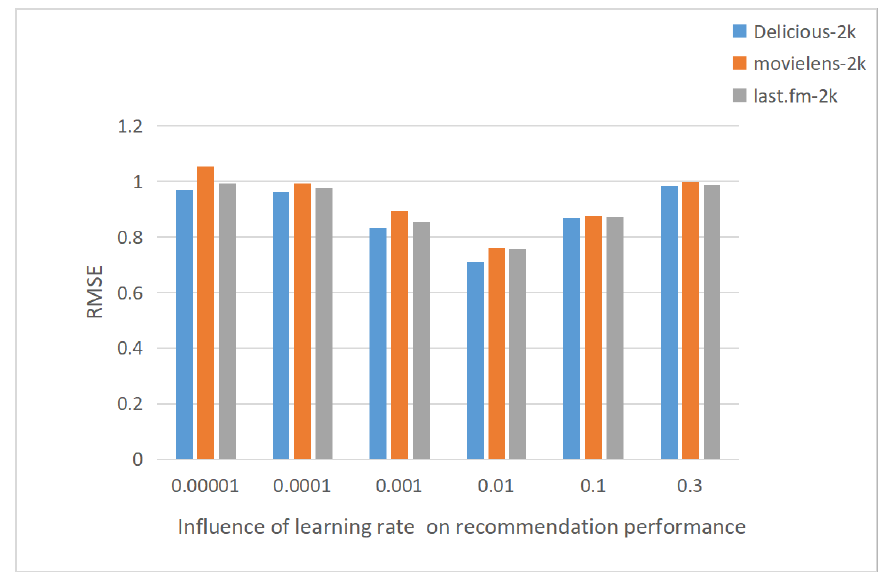
Figure 6. Influence of update rate α on recommendation performance.